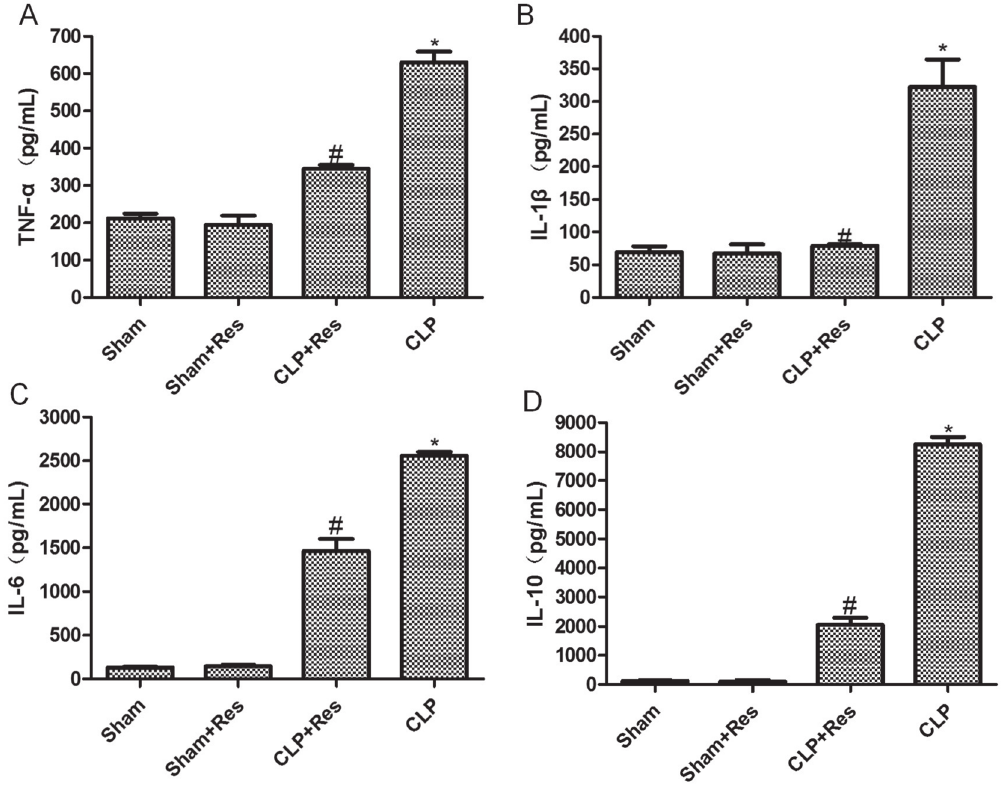
Fig. 7. Effects of resveratrol on serum (A) TNF-α, (B) IL-1β, (C) IL-6 and (D) IL-10 levels in septic rats 12 h after surgery. *Compared with Sham group, P <0.05; #compared with CLP group, P